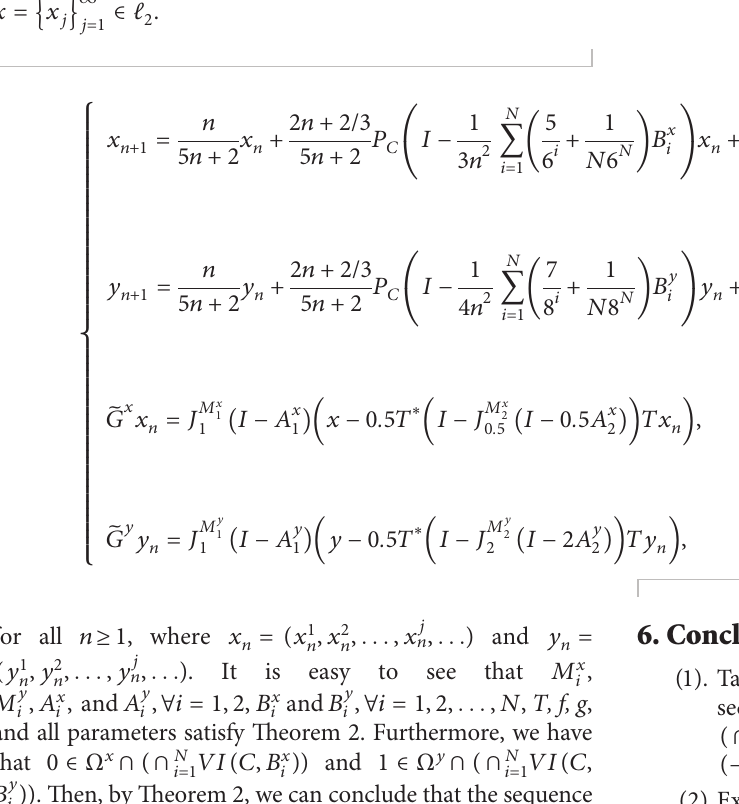
� (− 10 , 10 ) , and n � N � 1